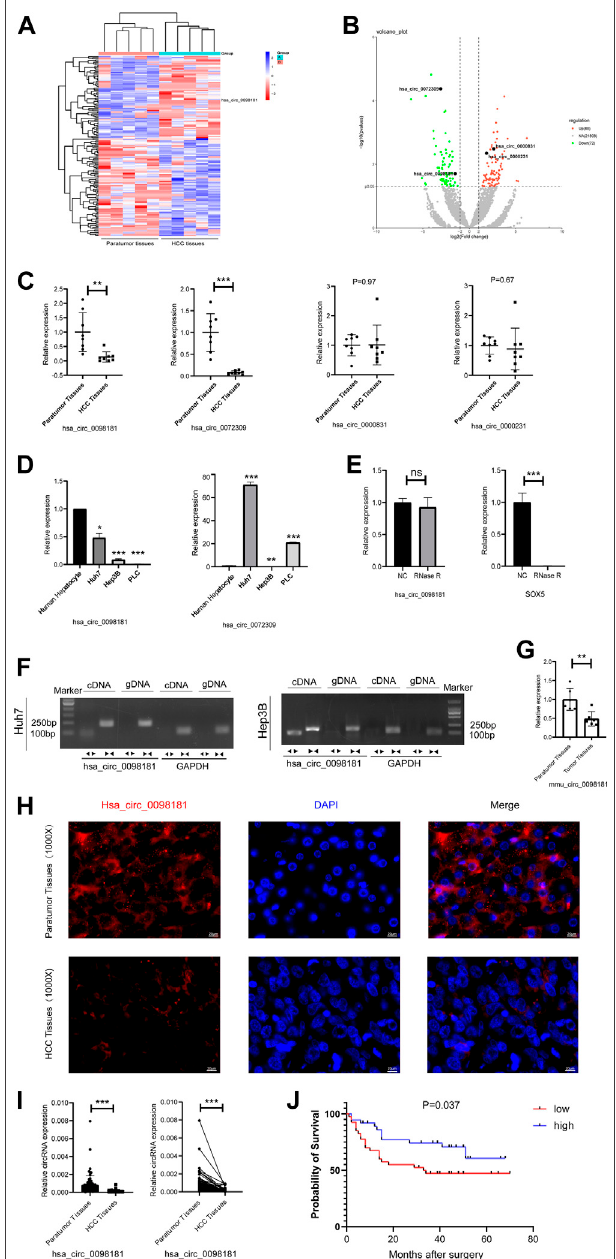
FIGURE 1 | Hsa_circ_0098181 decreased in HCC and reduction of hsa_circ_0098181 was related to the poor prognosis. (A,B) Differentially expressed